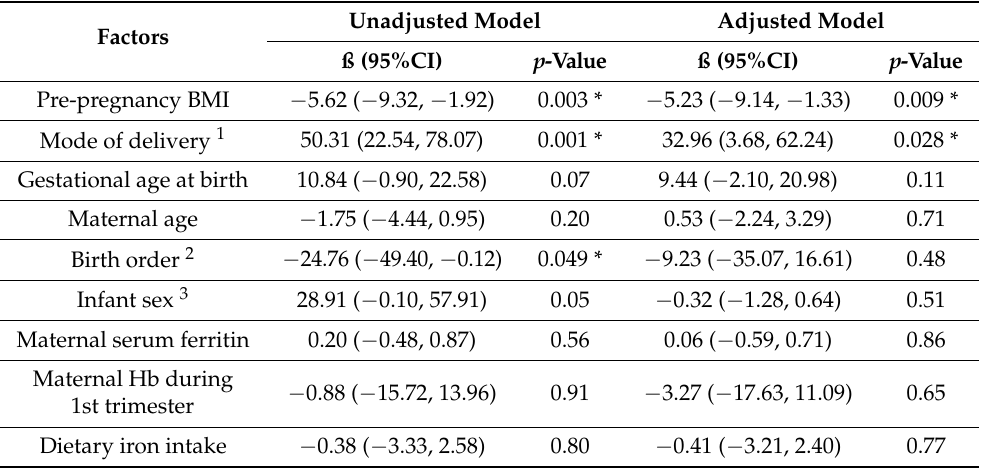
Table 4. Factors associated with cord blood